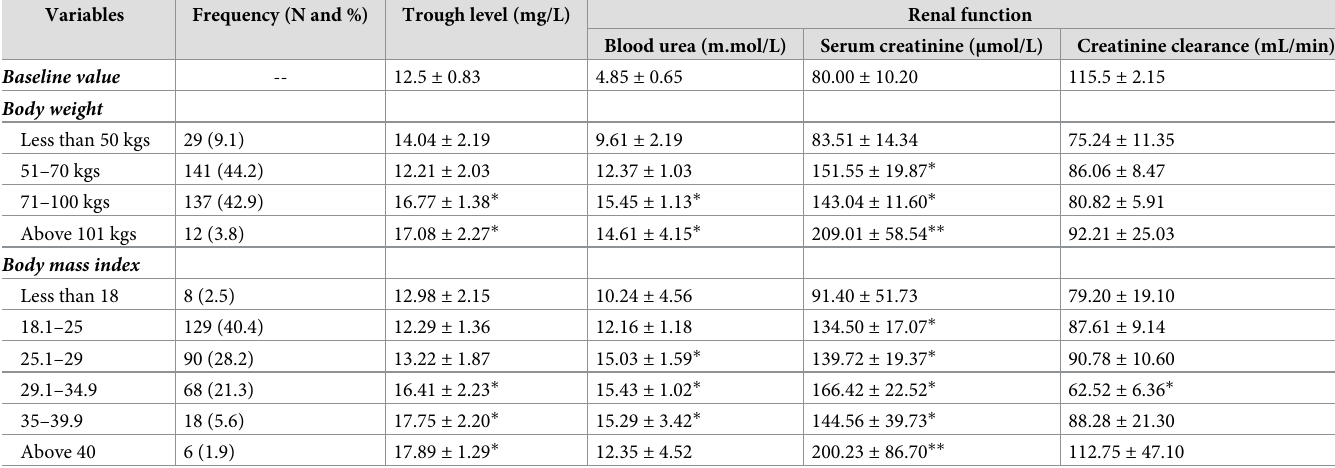
Table 2. Effect of vancomycin on renal functions in patients according to their body weight and body mass